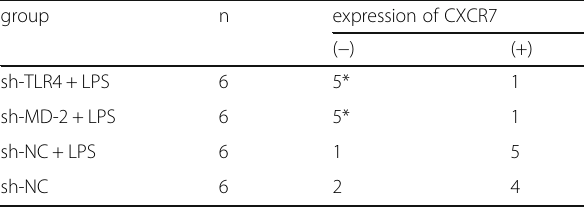
Table 4 The expression of CXCR7 protein in xenograft cells group n expression of